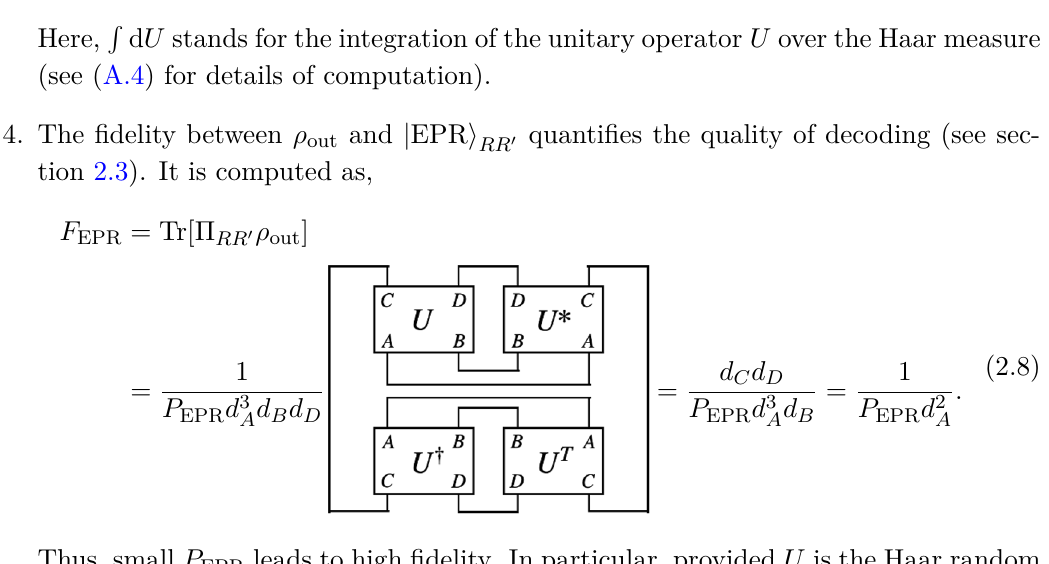
Figure 1 . The projection probability P EPR and decoding fidelity F EPR in the ideal case. The total system size is N = 10 , and the subsystem sizes are given by N A and N D . The left panel shows that the fidelity is close to unity for N A . N D